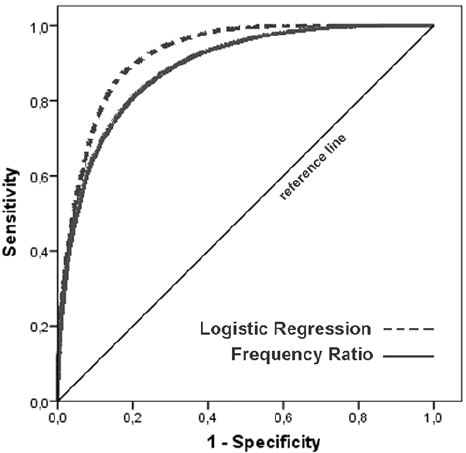
Fig. 7. ROC curves representing the prediction capability achieved Figure 7. ROC curves representing the prediction capability achieved by the Logistic 2 by the Logistic Regression and Frequency Ratio Regression and Frequency Ratio analyses. 3